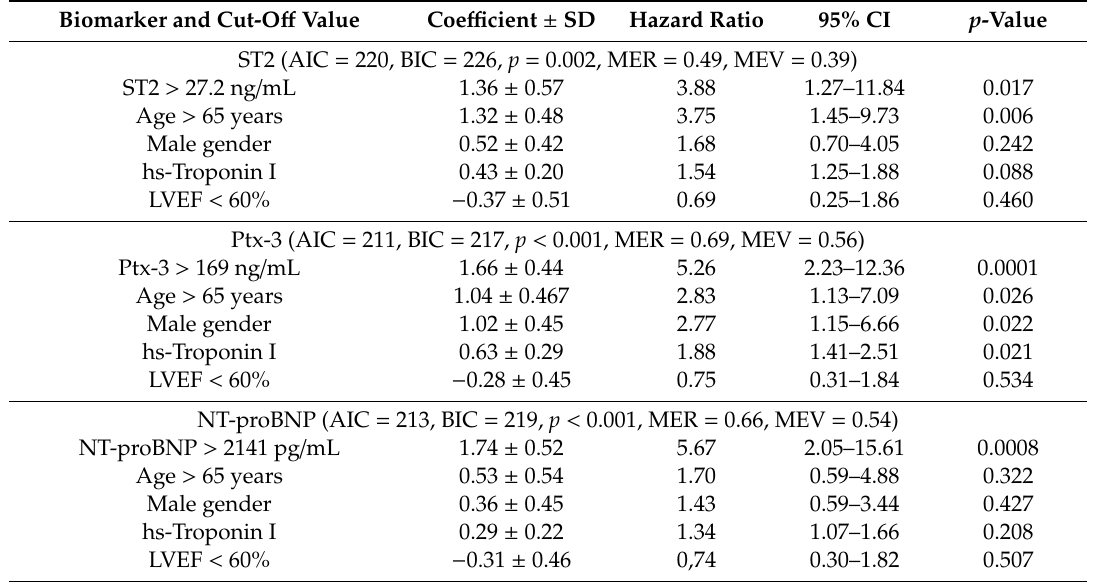
Table 7. Multivariate regression risk factors analysis for the prediction of CV mortality in two-year FU after